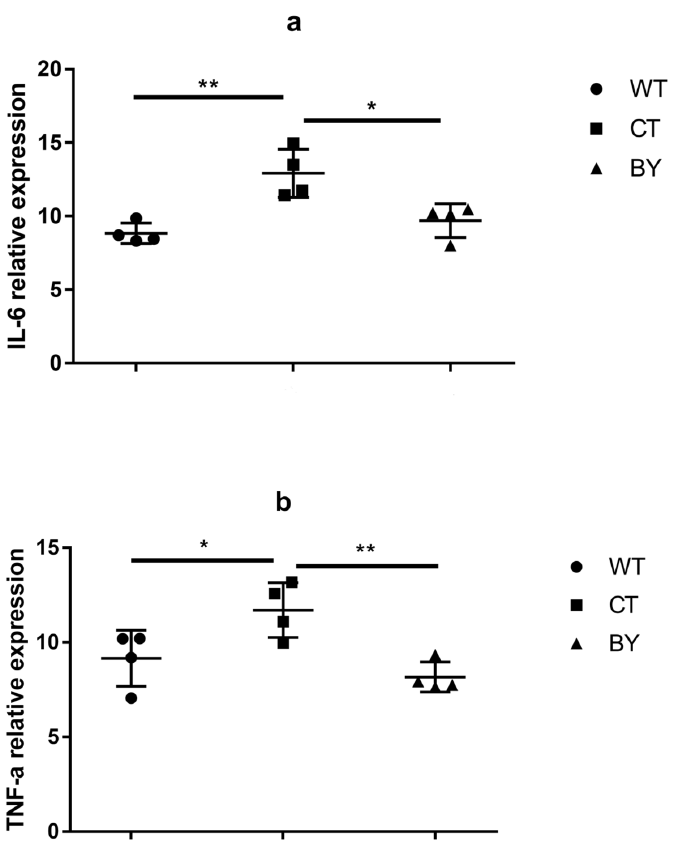
Figure 2. The relative expression of colitis inflammatory factors IL ‐ 6 ( a ) and tumor necrosis factor (TNF) ‐ a ( b ) of the proximal colons in three groups of mice. Wild ‐ type mice (WT), IL ‐ 10 − / − mice without treatment (CT), IL ‐ 10 − / − mice treated with butyrate (BY); Data are presented as mean ± SEM ( n = 4 for each group, * p < 0.05 and ** p < 0.01 versus CT group).